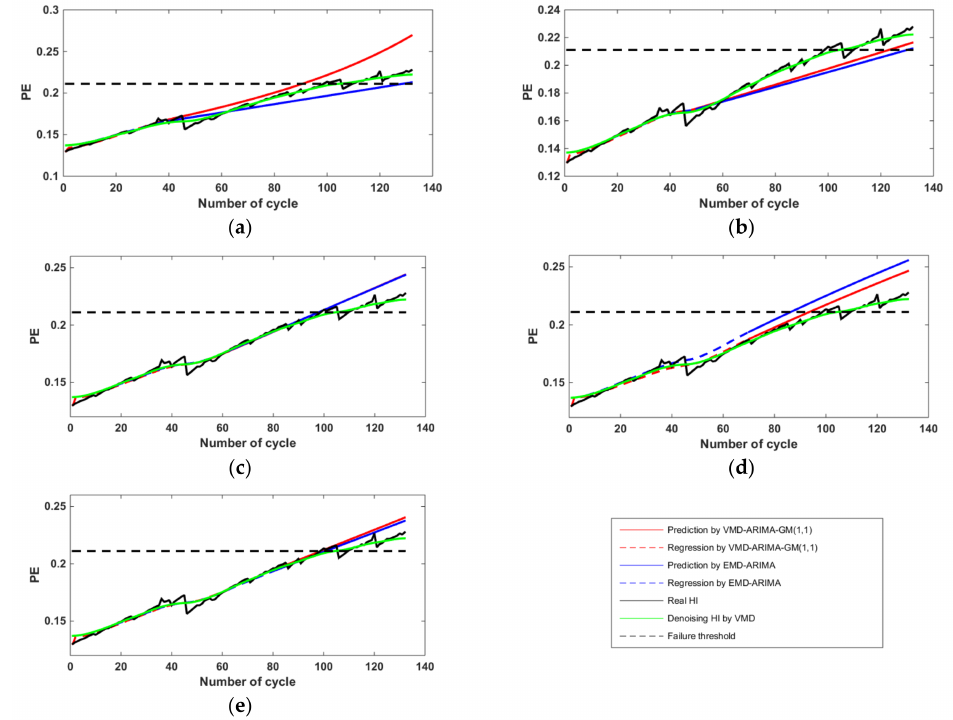
Figure 8. RUL prediction for battery No. 18 at ( a ) 40 cycles; ( b ) 50 cycles; ( c ) 60 cycles; ( d ) 70 cycles; ( e ) 80